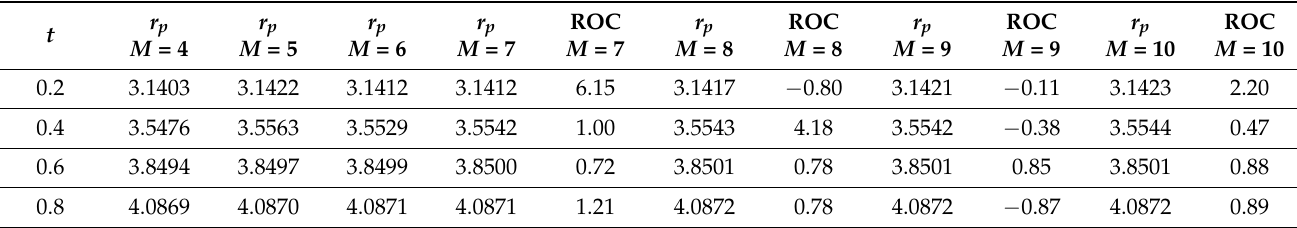
Table 6. The values of r p and rate of convergence (ROC) at different points for k = 2 and various values of M by Bernoulli wavelets.